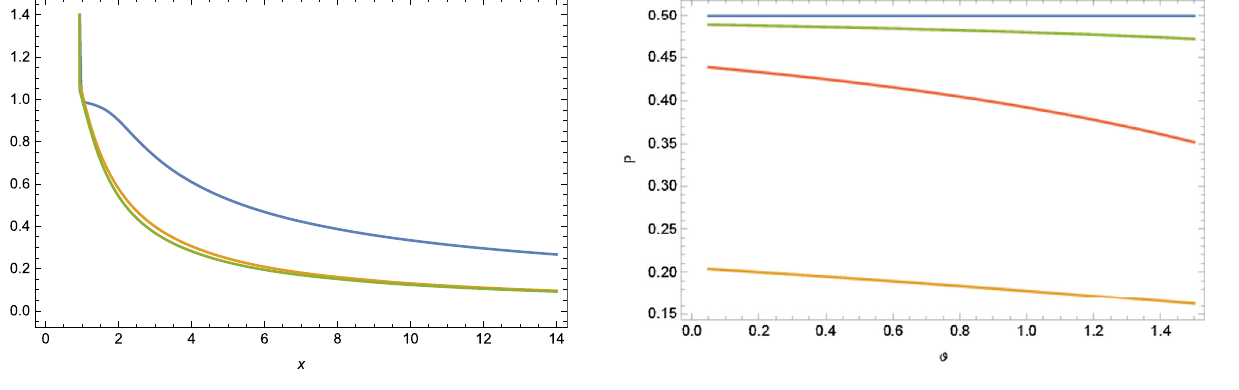
Fig. 1 Case 1. plot χ is function of x. For a r = 3, j c = 0 . 1 and ϑ = 0 . 5 (blue line), ϑ = 2 (orange line), ϑ = 4 (green line)